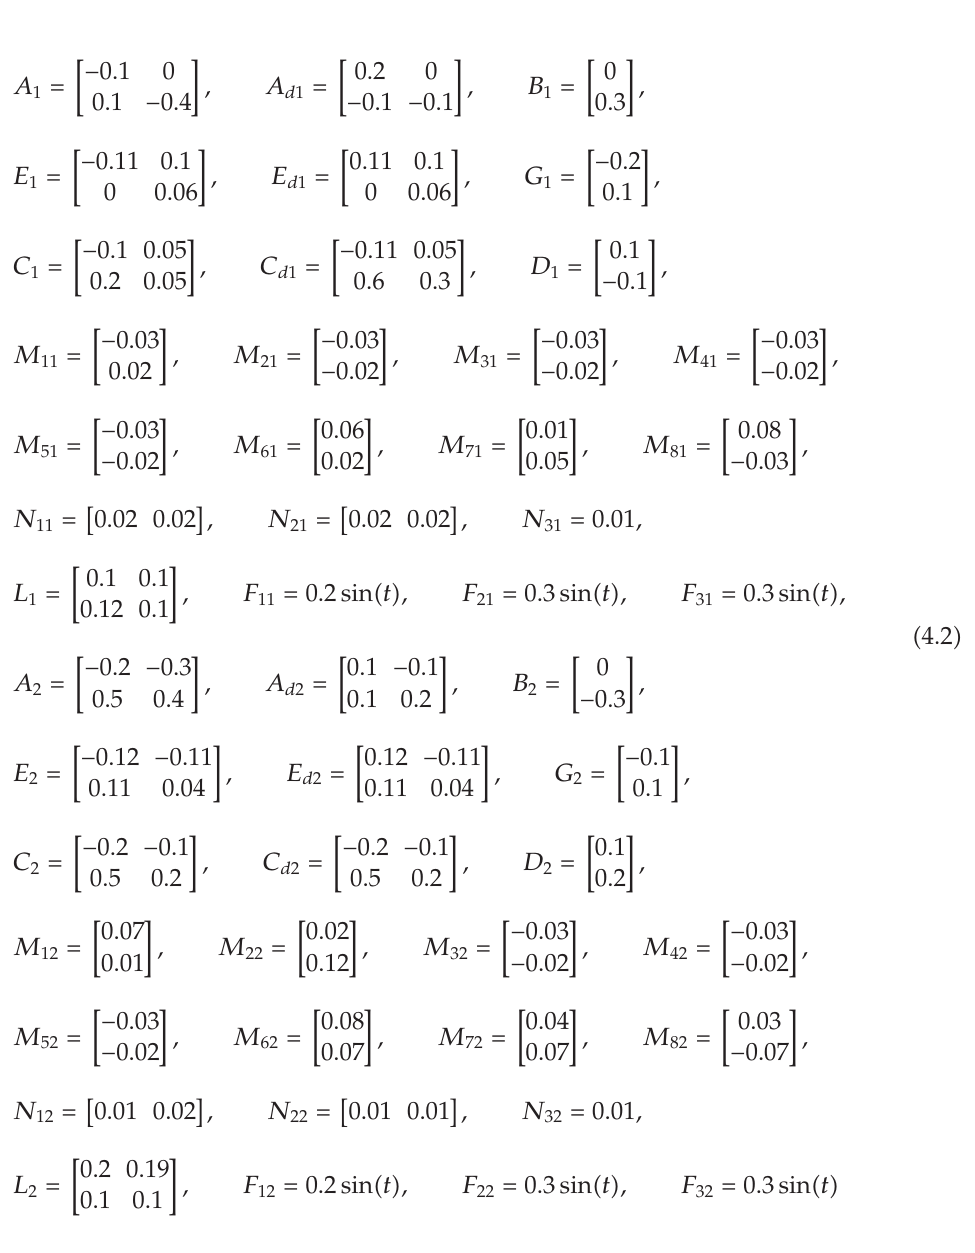
and v (cid:3) t (cid:4) (cid:8) 10 e − t , the membership functions are h 1 (cid:3) θ (cid:4) (cid:8) (cid:3) 1 − sin (cid:3) x 2 (cid:4)(cid:4) / 2, h 2 (cid:3) θ (cid:4) (cid:8) (cid:3) 1 − sin (cid:3) x 1 (cid:4)(cid:4) / 2, and the nonlinear vector function is φ (cid:3) u (cid:4) (cid:8) (cid:3) K 2 (cid:10) K 1 (cid:4) / 2 (cid:10) (cid:3) K 2 − K 1 (cid:4) / 2 sin (cid:3) u (cid:4) , K 1 (cid:8) diag { 0 . 1 , 0 . 3 } , K 2 (cid:8) diag { 0 . 2 , 0 . 4 }